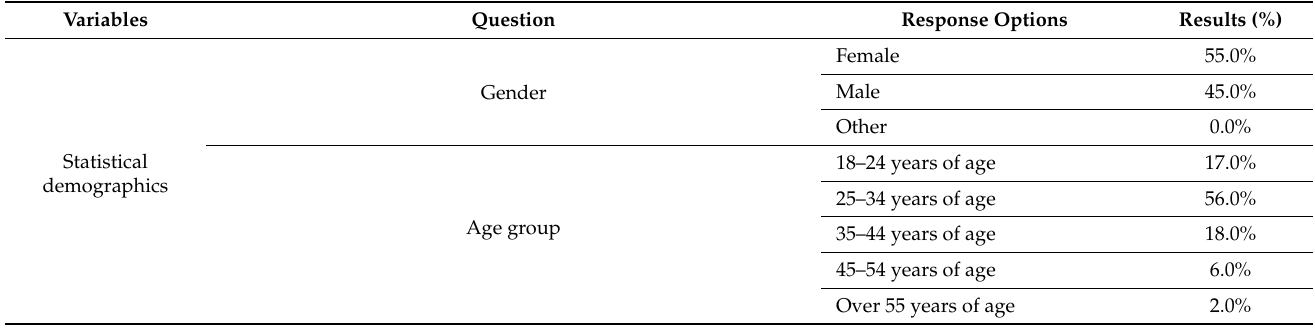
Table A1. Frequencies of the Variables